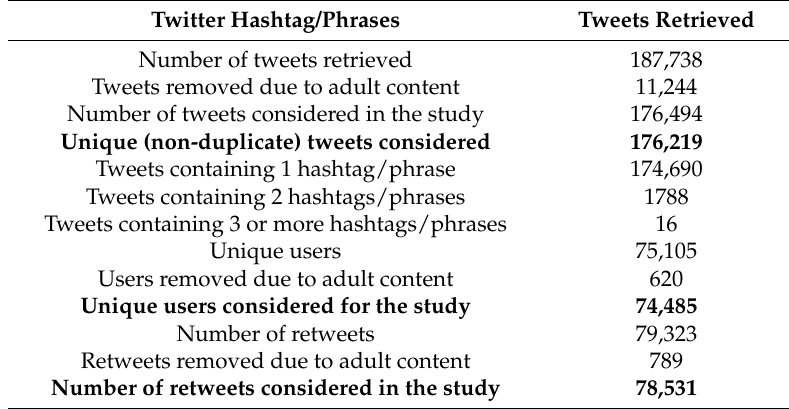
Table 6. General